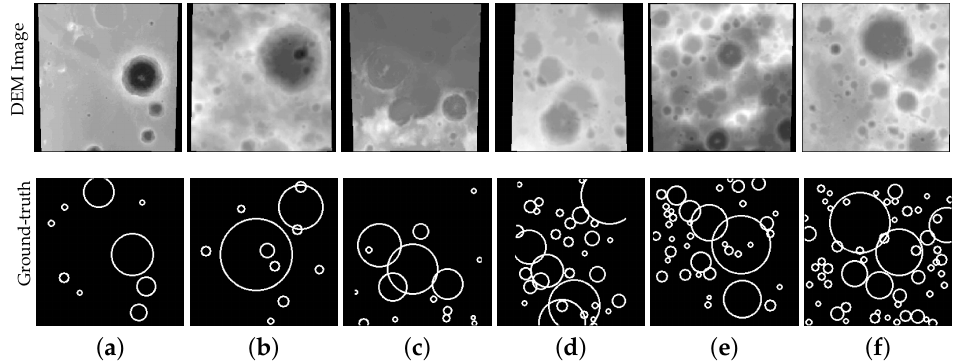
Figure 3. The different characteristics of craters on the surface of the Moon from DEM data. The top figure is the original crater images, and the bottom figure denotes the labeled images denoted as the ground truth. ( a – c ) show the distribution of sparse craters, ( d – f ) denote the distribution of dense craters, ( b – f ) represent the different degrees of crater overlap, ( c – f ) show the incomplete